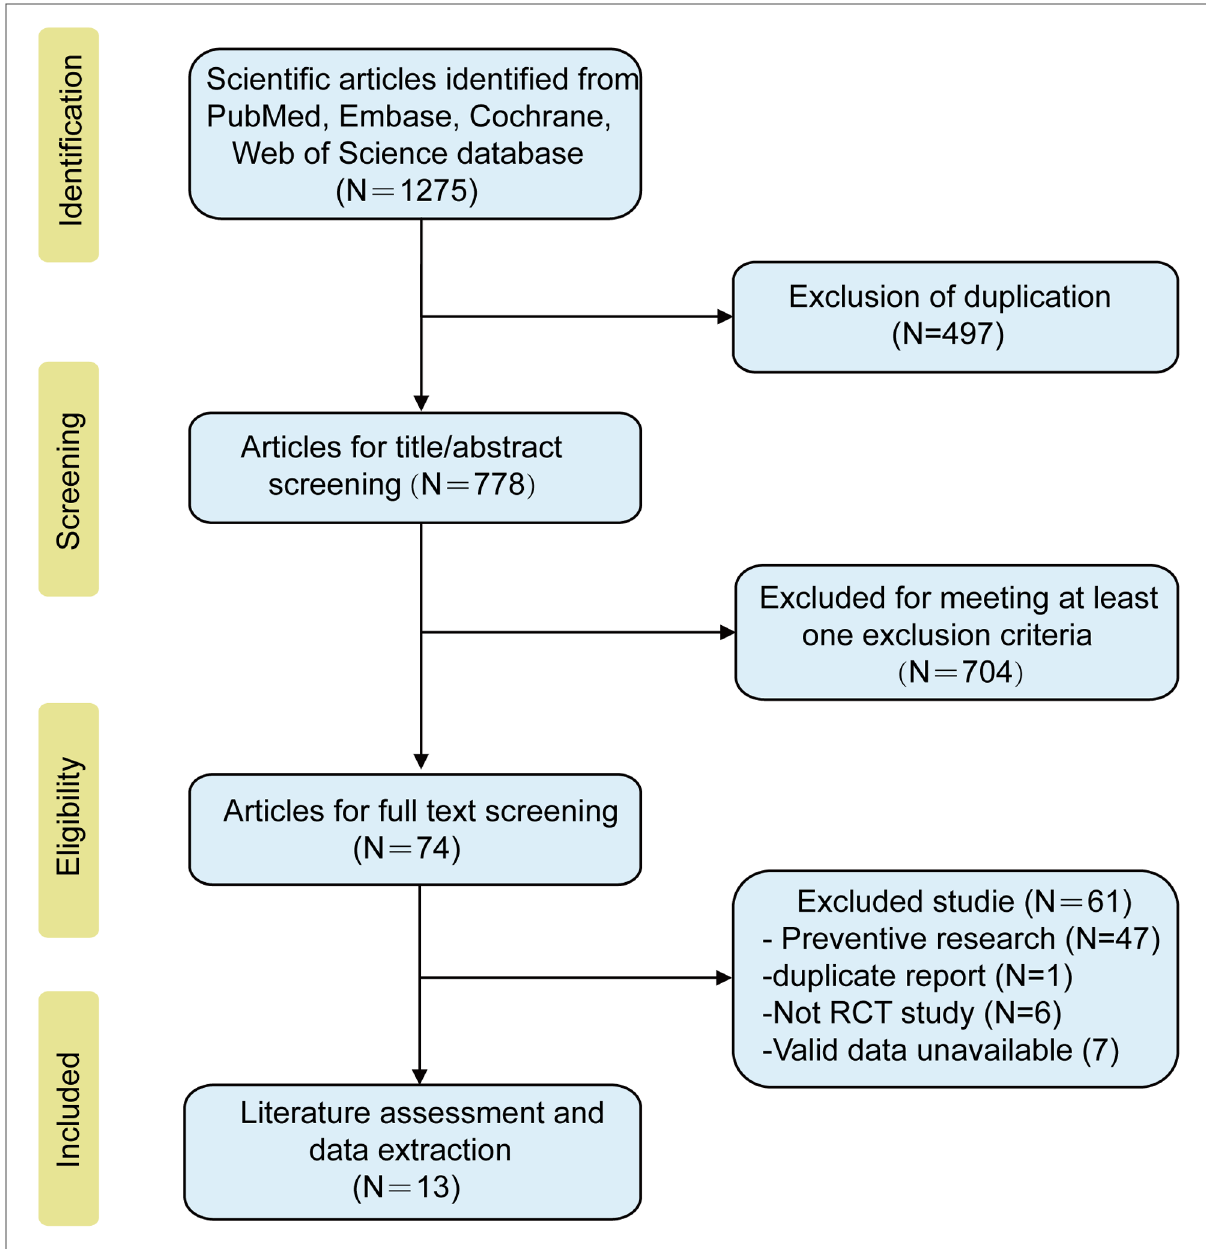
FIGURE 2 PRISM fl ow diagram of the study selection for this Bayesian network